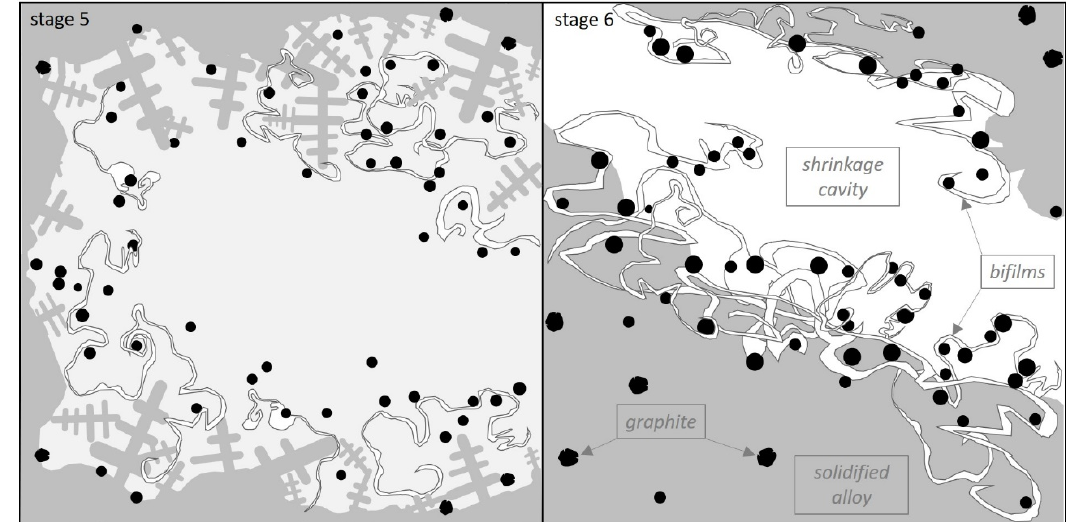
Figure 8. Creation process of shrinkage cavity ( stage 5 ). Shrinkage cavity with primary graphite nodules mixed and trapped with the bifilm inclusions ( stage 6 ).